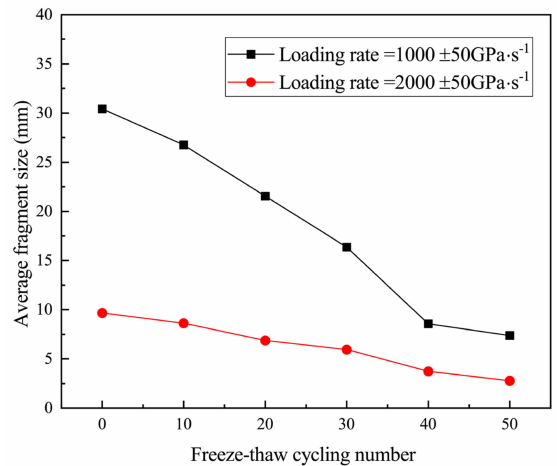
Figure 15. Dissipated energy vs. dynamic compression